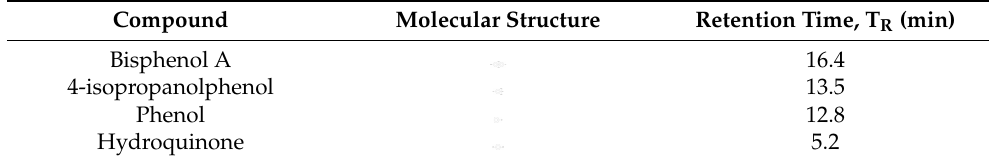
Table 2. Compounds recognized from HPLC/MS analysis of photocatalytic degradation of